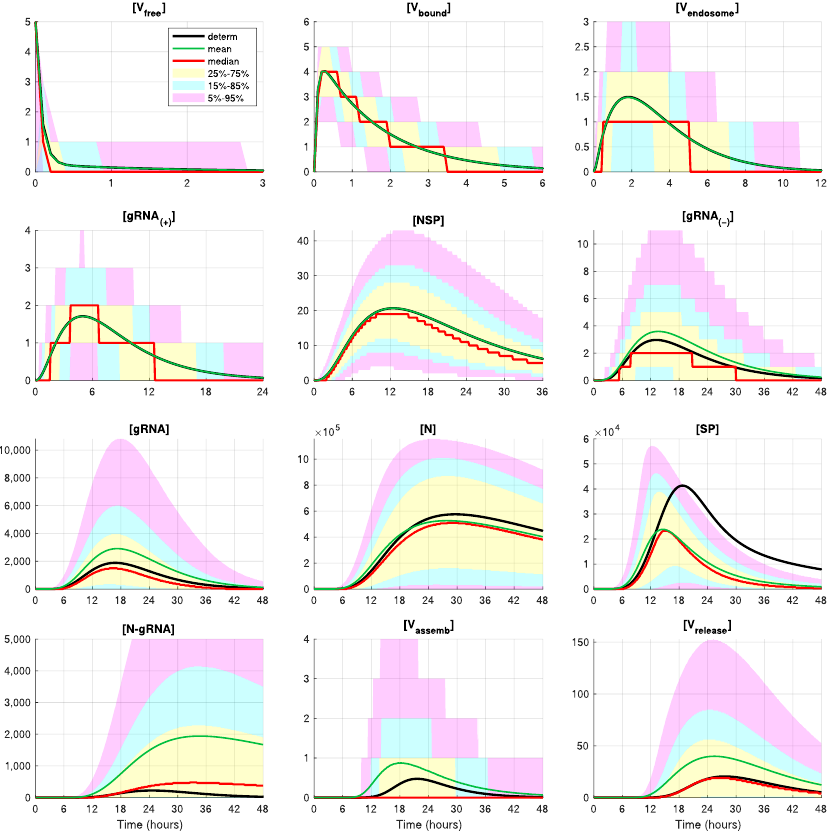
Figure 4. Evolution of the confidence intervals for all 12 species participating in the SARS-CoV-2 replication for [ V free ]( 0 ) = 5. The green, red, and black lines indicate the mean, median, and the deterministic solution,